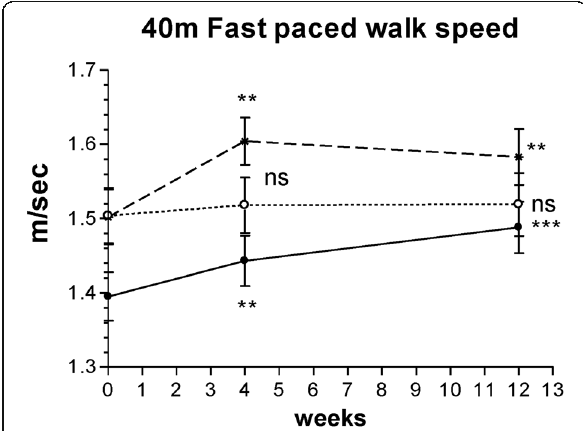
Safety The treatments were all well tolerated. In total, 13 AEs were observed in 13 of the 201 patients: 4 in the placebo group, 2 in the Curamin group and 7 in the CuraMed group, Table 7. Serious AEs were not observed. The pa- tients who reported these minor events were distributed evenly throughout the Curamin group (3% of the sample size), the placebo group (5.9% of the sample size) and the CuraMed group (10.6% of the sample size). It is noteworthy that nausea was observed only in patients taking curcumin-containing supplementations. Serious AEs were not observed. Analysis of AEs observed in both the treatment and placebo groups revealed that the